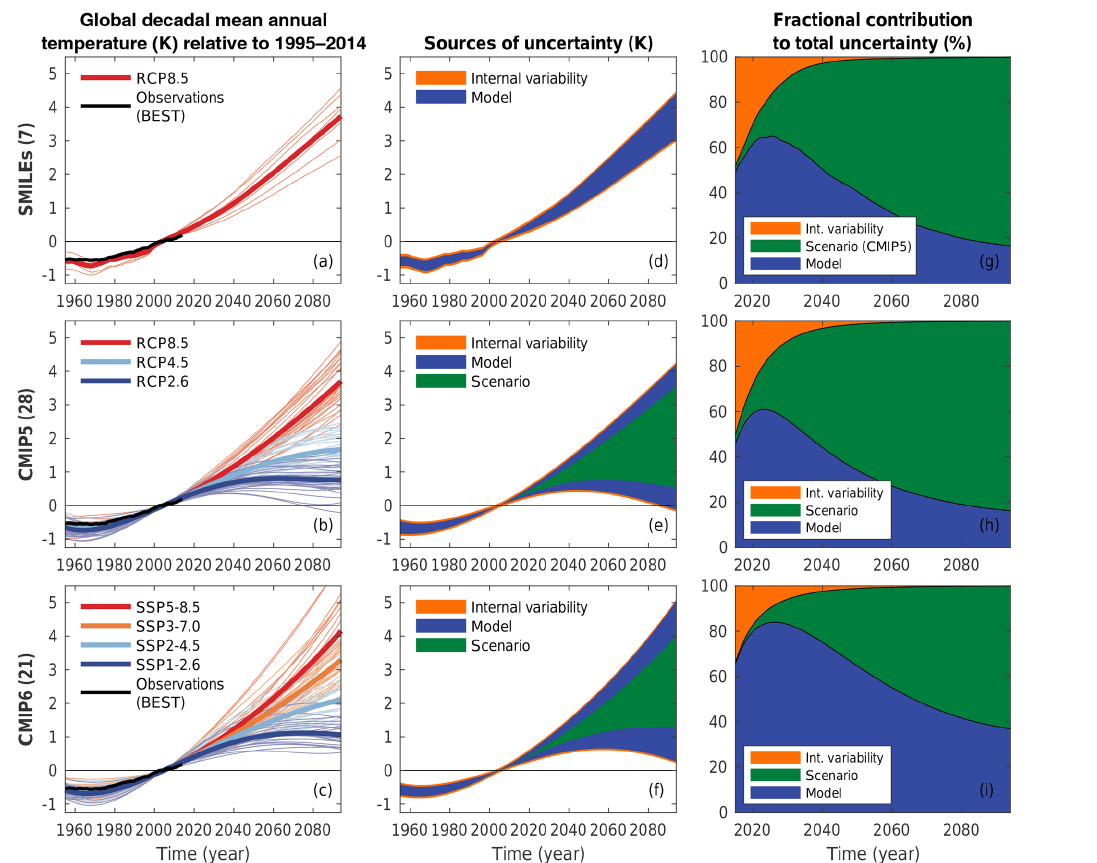
Figure 1. (a–c) 10-year running means of global annual mean temperature time series from (a) SMILEs, (b) CMIP5 and (c) CMIP6, with observations (Rohde et al., 2013) superimposed in black, all relative to 1995–2014. For SMILEs, the ensemble mean of each model and the multimodel average of those ensemble means are shown; for CMIP the polynomial fit for each model and the multimodel average of those fits are shown. (d–f) Illustration of the sources of uncertainty in the multimodel multi-scenario mean projection. (g–i) Fractional contribution of individual sources to total uncertainty. Scenario uncertainty in SMILEs in (g) is taken from CMIP5, since not all SMILEs offer simulations with multiple scenarios. (d–i) In all cases, the respective multimodel mean estimate of internal variability ( I mean ) is used.